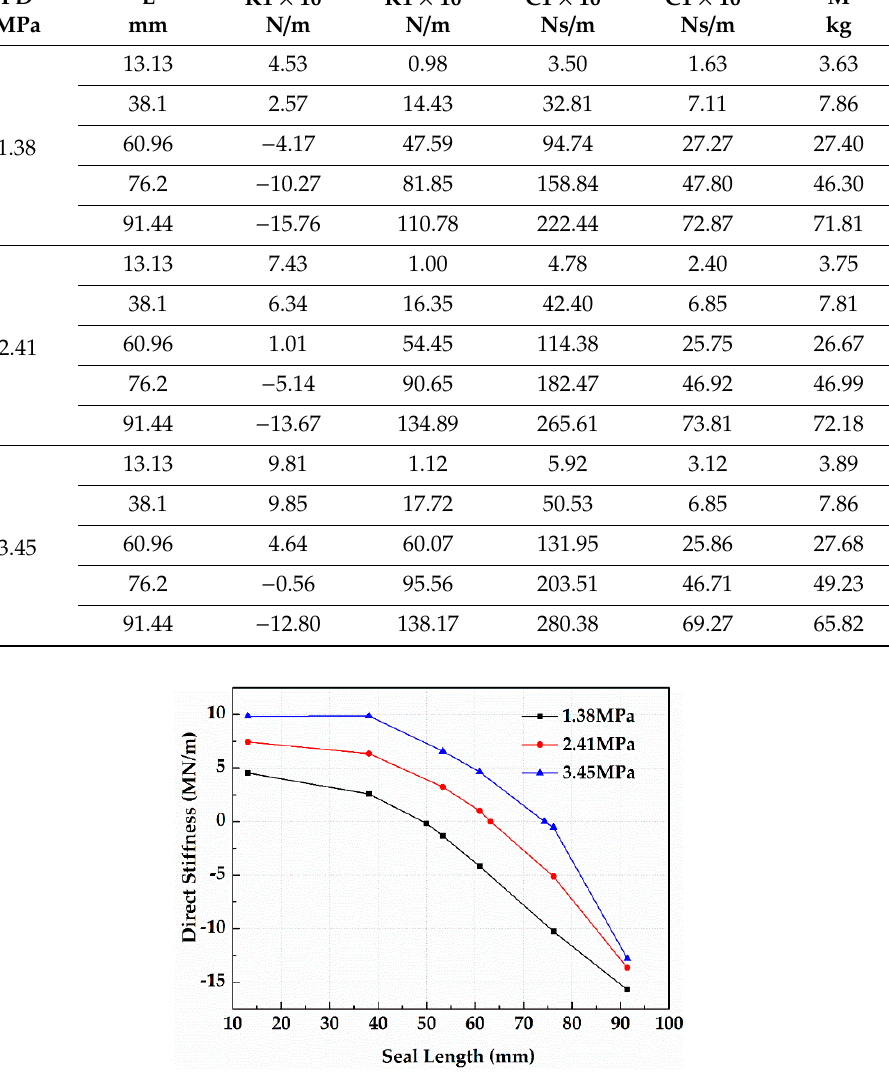
Figure 10. Direct stiffness for different seal lengths.